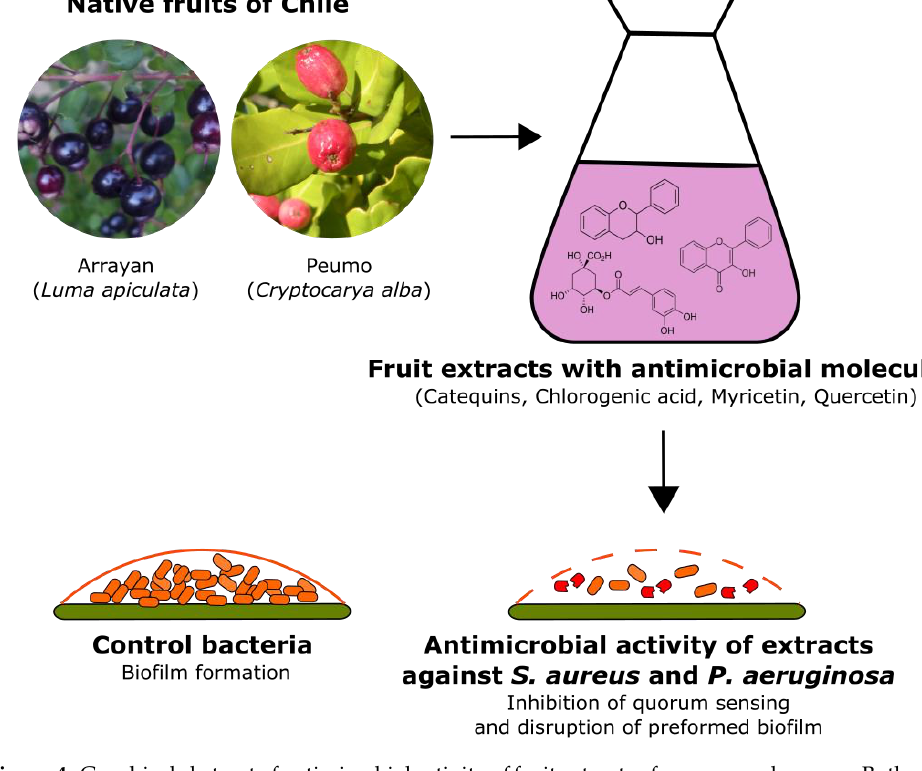
were confirmed by inhibition of cell adhesion mediated by the cell-to-cell communication (Table 5). The two assays confirmed that the better extract for inhibition of bacterial communication is arrayan extract when applied on bacteria using the AI-2 type of communication. On the basis of our knowledge, this is the first paper reporting on the ability of arrayan fruit to inhibit bacterial